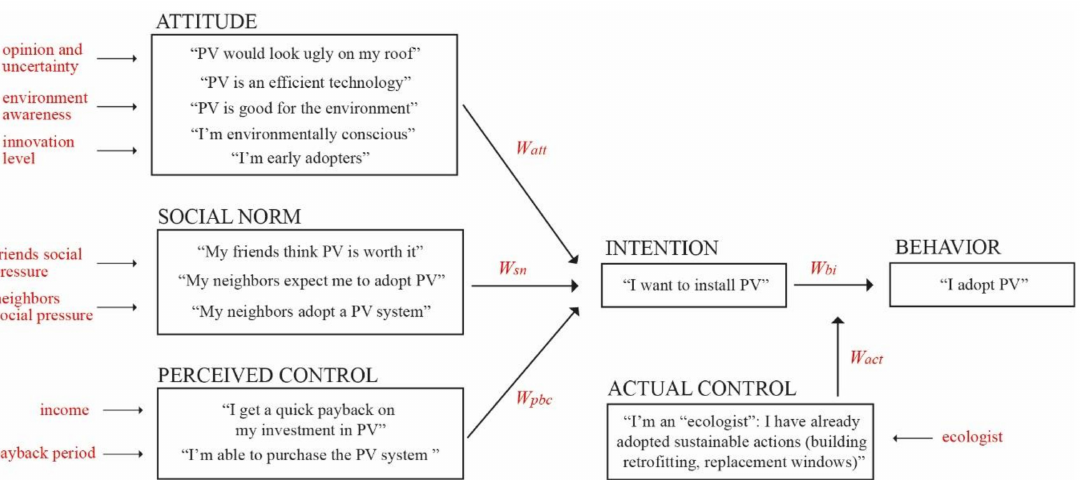
Figure 3. Components of the behavior for PV adoption (adapted from Ajzen (2002) and Robinson et al.